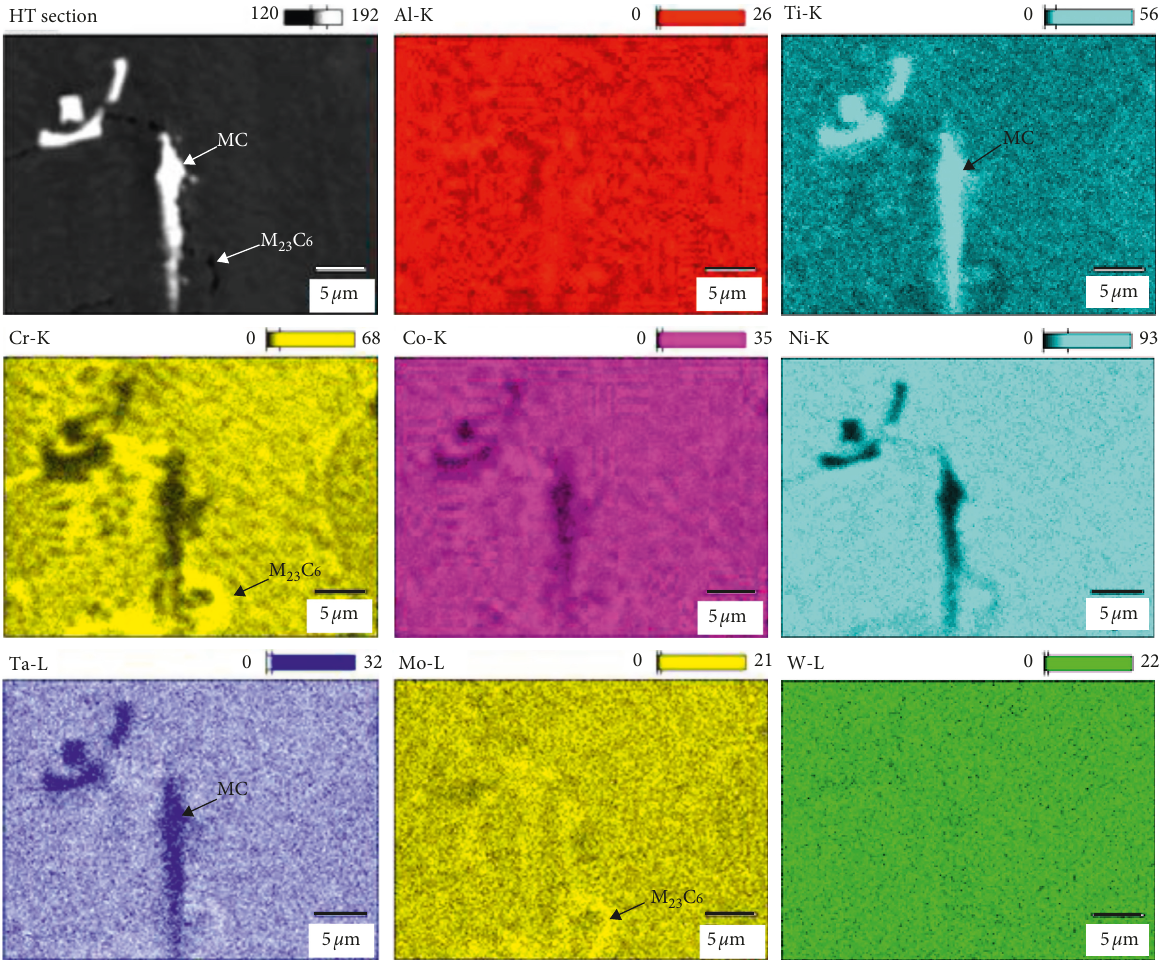
Figure 10: Element-imaging SEM analysis of IN-792 superalloy for HT